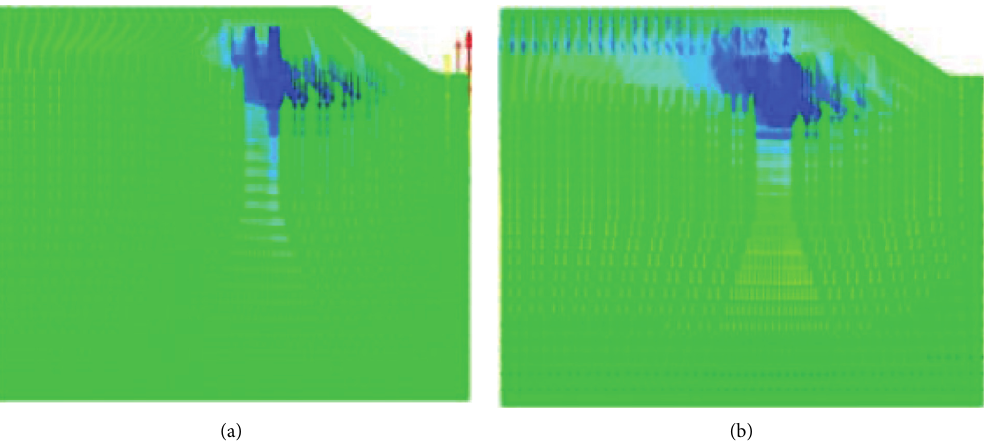
Figure 4: Settlement vector diagram of the widened subgrade for a pile spacing under the existing road slope equal to 300% of the pile diameter. (a) Settlement vector diagram of subgrade completion. (b) Settlement vector diagram 15 years after subgrade